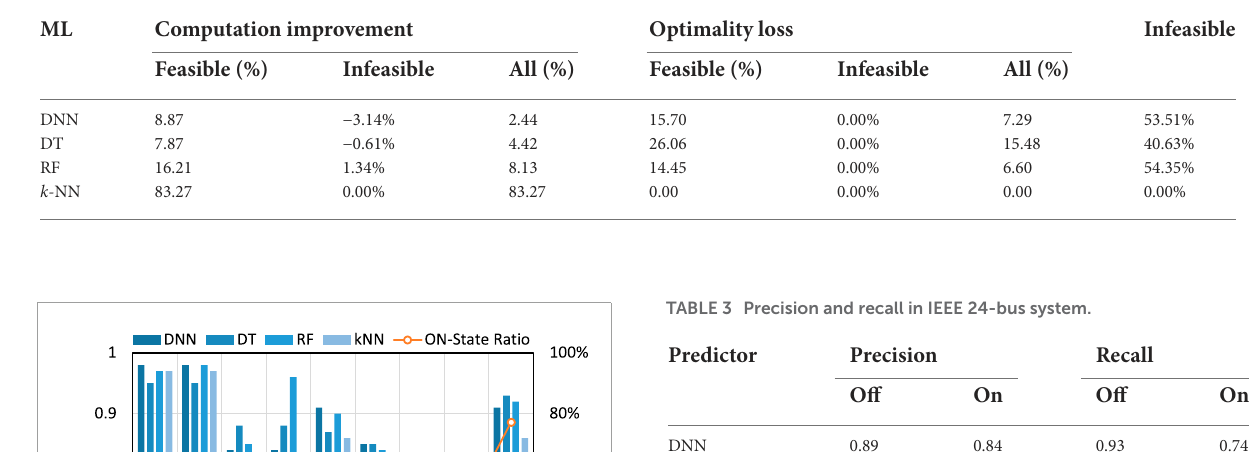
TABLE 2 ComputationimprovementandoptimalitylossinIEEE24-bussystem.